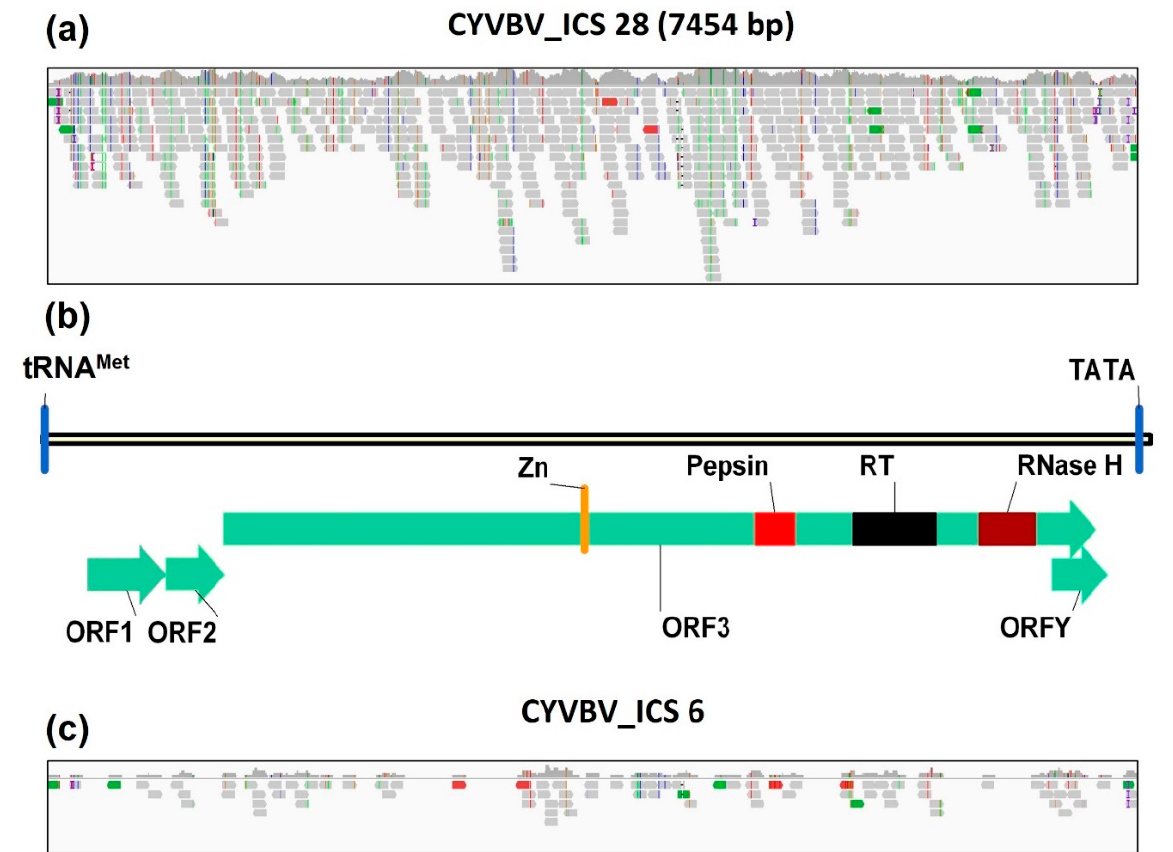
Figure 6. Genome coverage and organization. Sequence reads mapped to reference genome (GenBank Accession KX276641) of cacao yellow vein-banding virus (CYVBV) from SRR7961402 ( a ) and SRR7774312 ( c ) libraries. ( b ) Linear map of CYVBV genome assembled from ICS 28 (SRR7961402) library showing the putative tRNA met -binding site (tRNA met ) and TATA box; predicted open reading frames (ORF)1, ORF2, ORF3 and ORFY; and predicted conserved domains including zinc knuckle finger (Zn), pepsin-like aspartate protease (Pepsin), reverse transcriptase (RT) and ribonuclease H (RNase H).